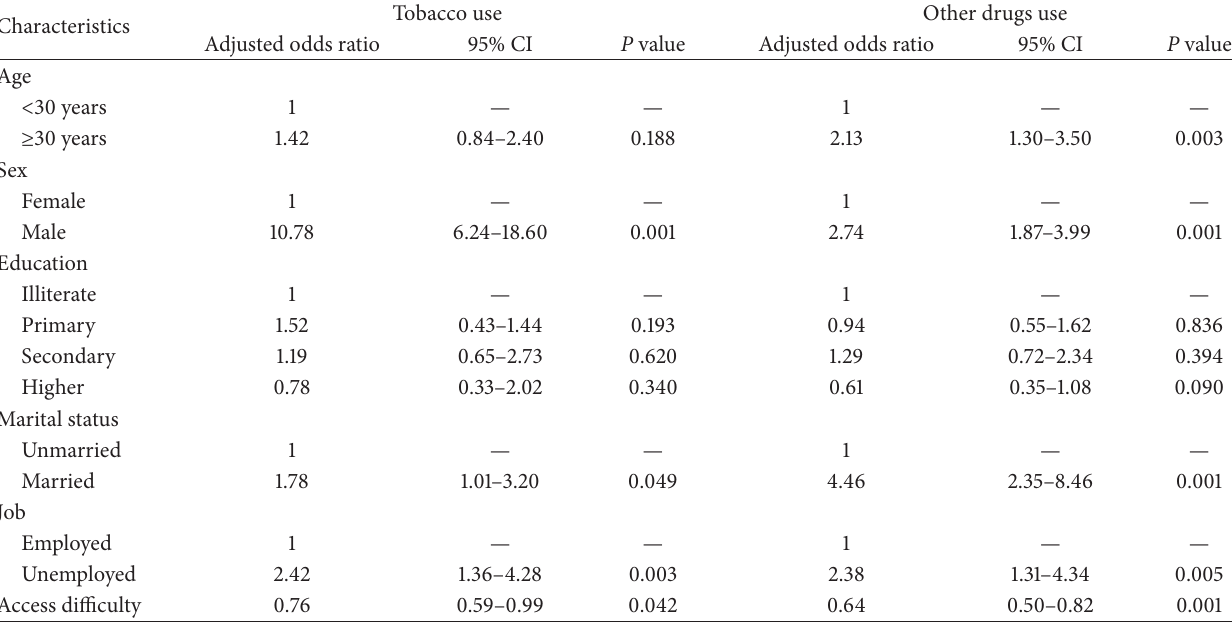
Table 6: Logistic regression analysis to examine baseline characteristics associated with tobacco and other drugs use.